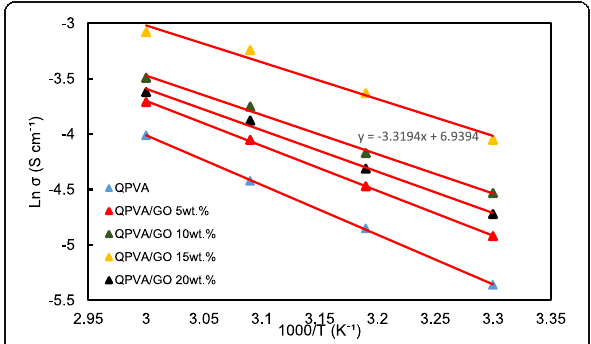
Fig. 12 Ln σ vs. 1000/T plot for the QPVA/GO composite membrane; the lines indicate the linear regression